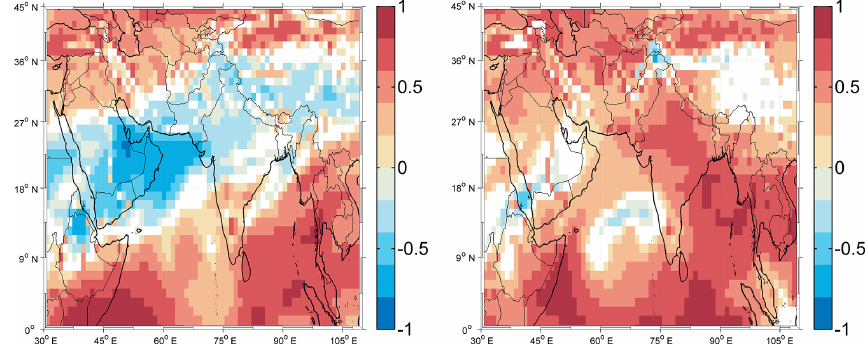
Figure 11. O 3 –CO correlations calculated for 4–8km column abundances with 3h temporal interval in April 2008 (left panel) and 2006 (right panel) from MACC reanalysis data.